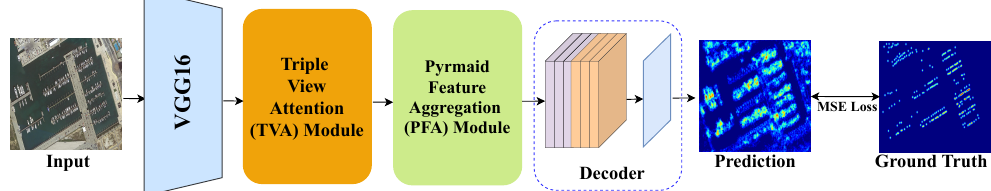
Figure 2. Architecture of the TASNet for object counting in remote sensing.